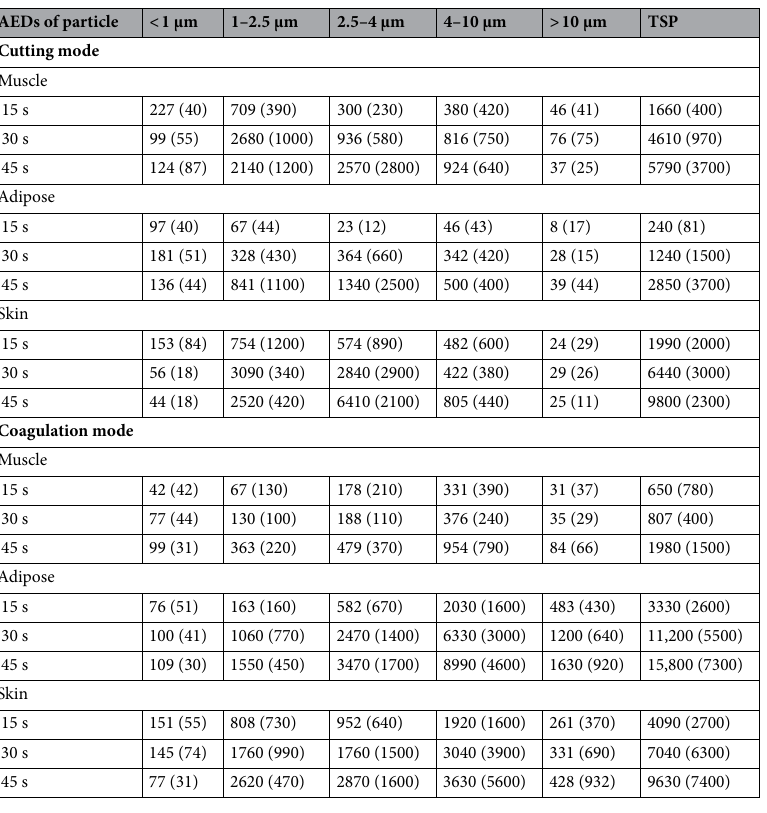
Table 1. The concentration [mean (SD), μg/m 3 ] of various aerodynamic equivalent diameters (AEDs) of particle in different tissues of the porcine model using coagulation and cutting modes under 30 W power. TSP total suspended